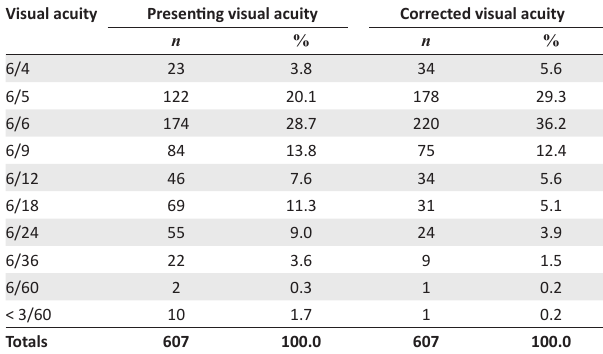
TABLE 3: Presenting and corrected distance visual acuities (at 6